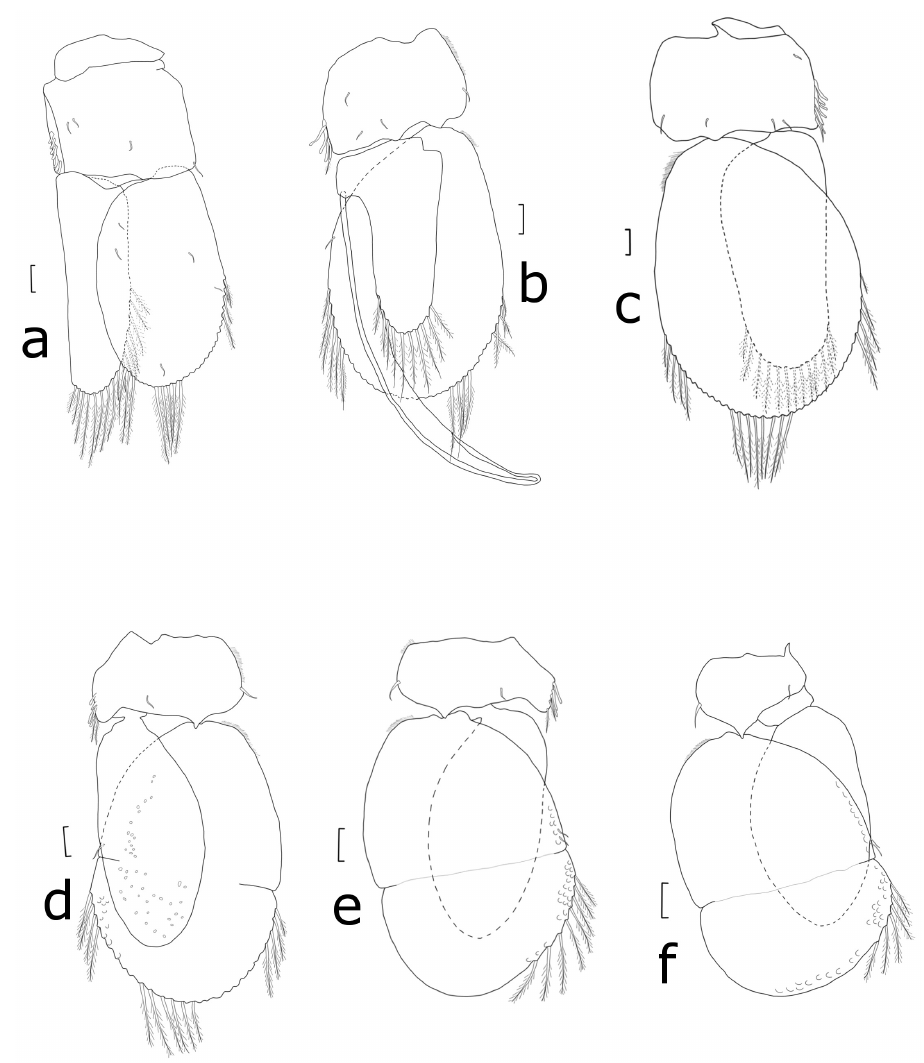
Figure 5. Typhlocirolana longimera sp. n. a pleopod 1 b pleopod 2 c female pleopod 2 d–f pleopods 3–5. Scale: a–f = 0.1